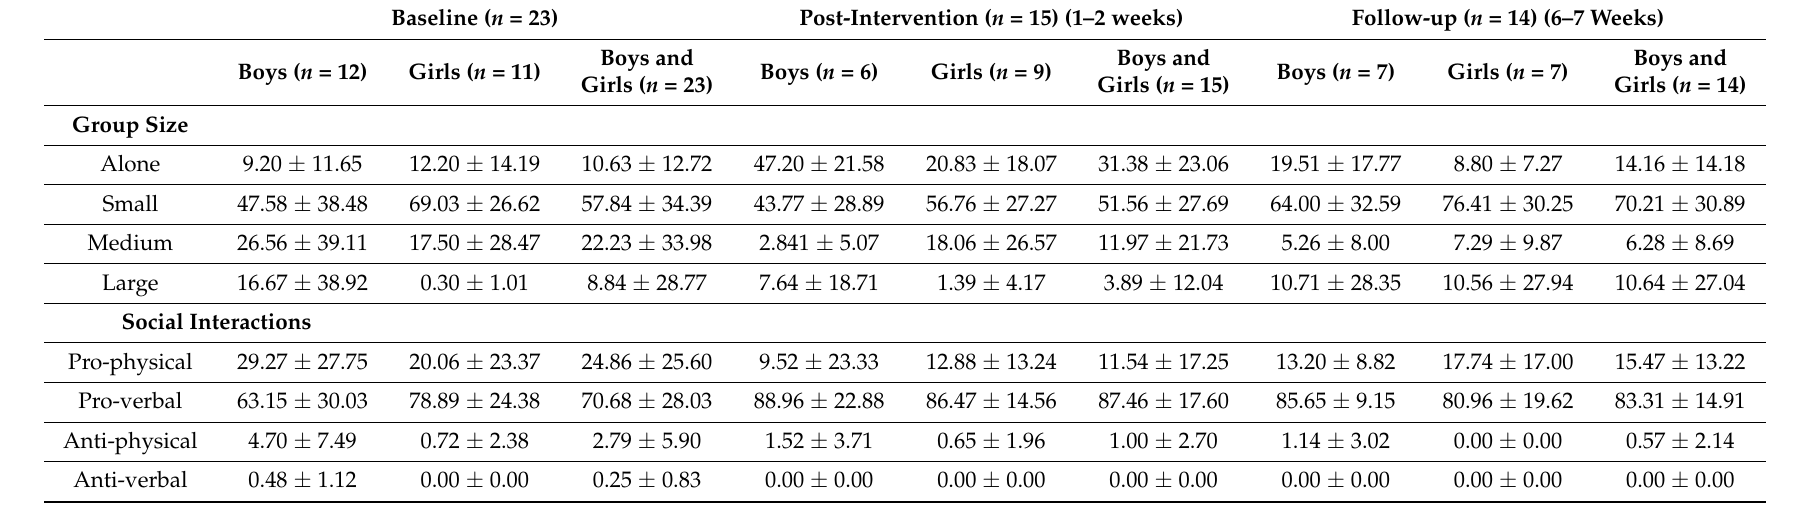
Table 4. Changes in Y3 and Y4 mean ( M ± SD ) percentage (%) of morning break times spent in the SOCARP activity variables of: ‘group size’ and ‘social interactions’ at baseline, post-intervention, and follow-up data collection